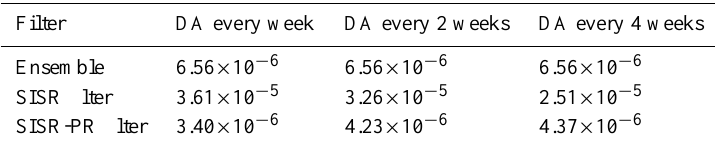
Fig. 7. SISR-PR filter performance and assimilation impact on the baseflow with parameter perturbation. The soil moisture and baseflow time series correspond to the DA study performed with set 2 as the initial parameter set. Table 5. RMSE [mm · s − 1 ] between the observed and simulated baseflow for 3 DA frequencies. SISR-PR is applied with parameter